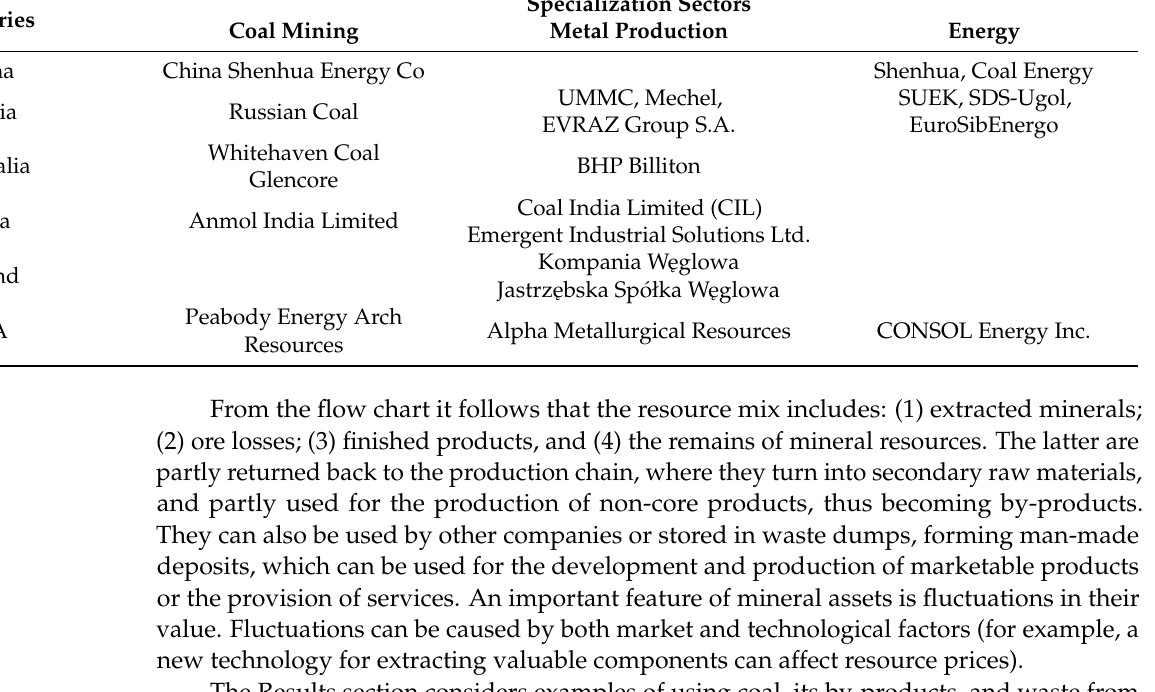
Table 1. Examples of companies by specialization. Source: compiled by the authors based on [58–60].